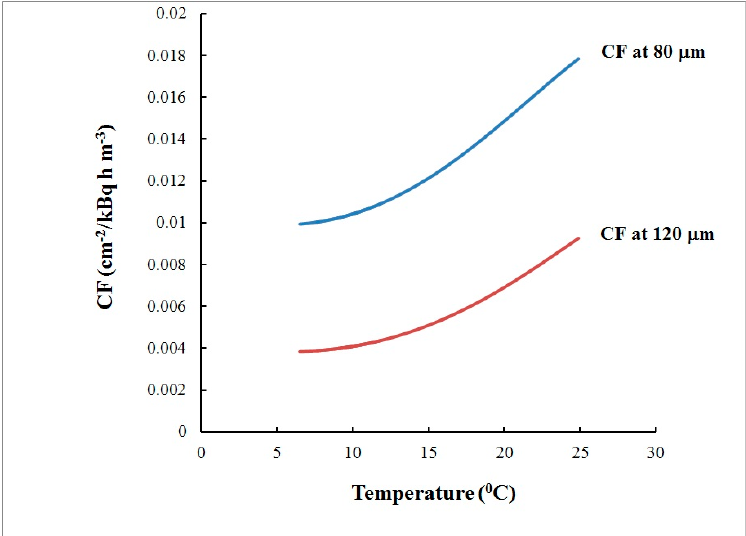
Figure 7. Dependence of the modeled calibration factor [11] on the temperature within 6.5–24.6 °C at depths of 80 µm and 120 µm.